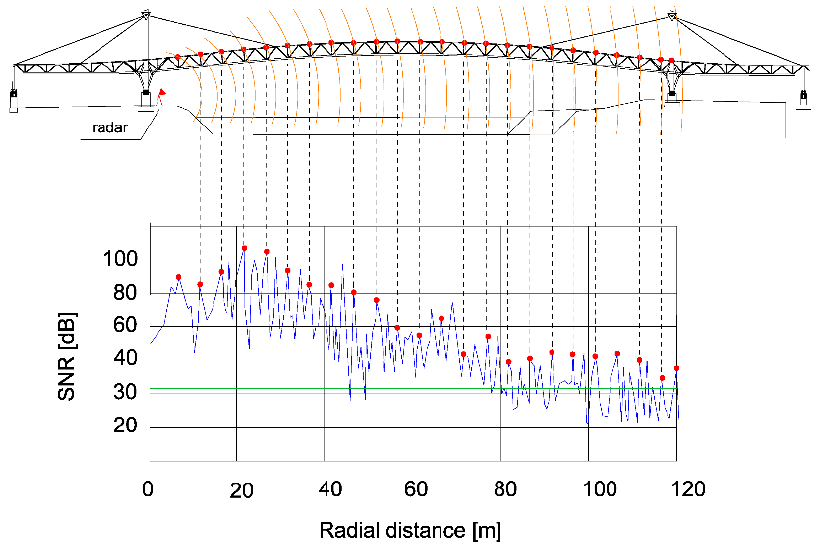
Figure 2. Principle of the targets’ identification in the radial direction.